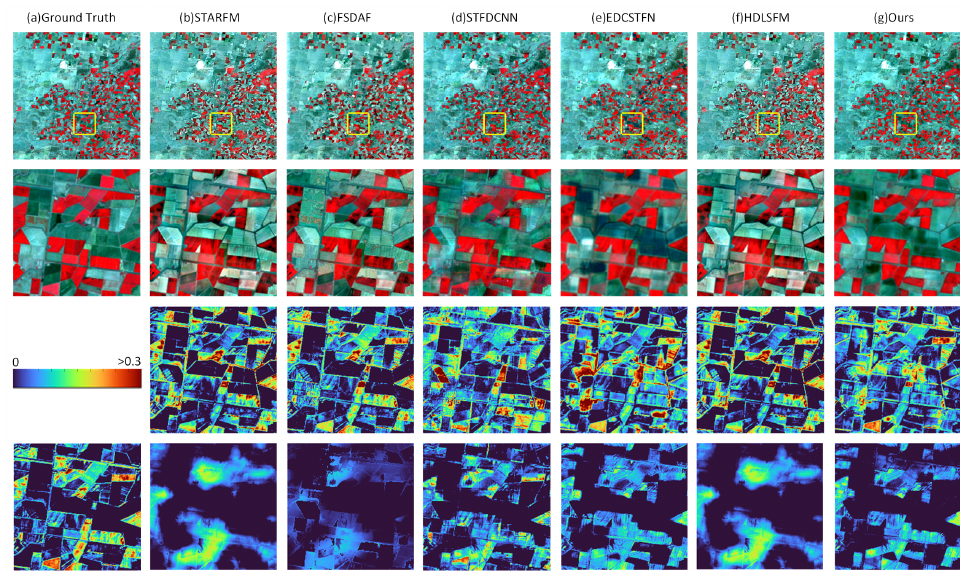
Figure 14. The fusion results on 12 February 2002 in CIA (The arrangement of the subfigures is the same as above).